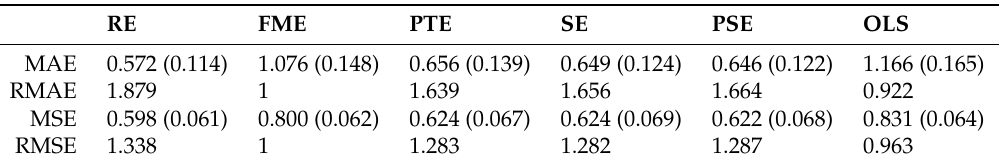
Table 11. Comparison of forecasting